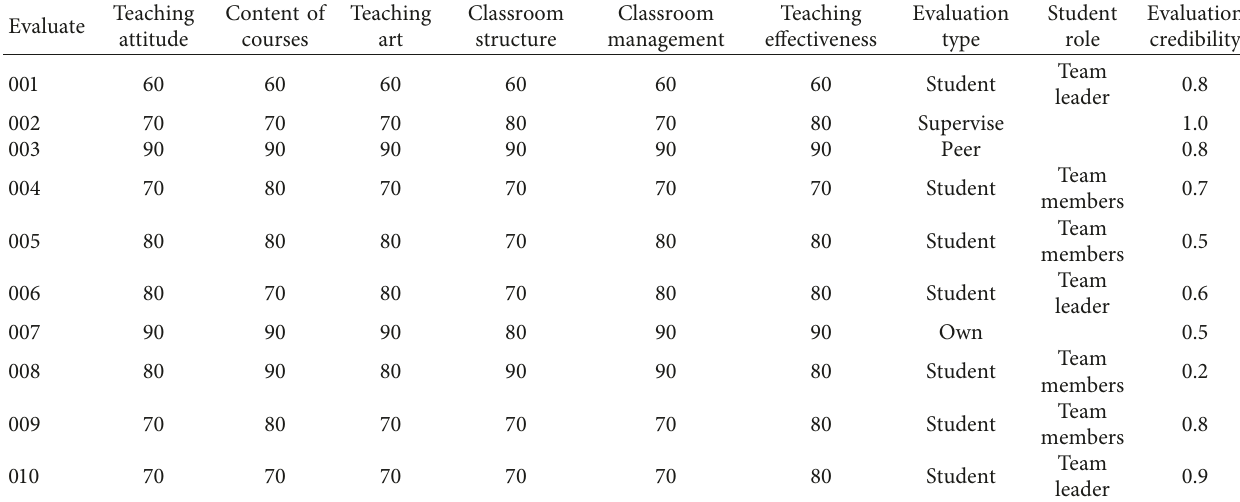
Table 12: Teaching quality evaluation database.